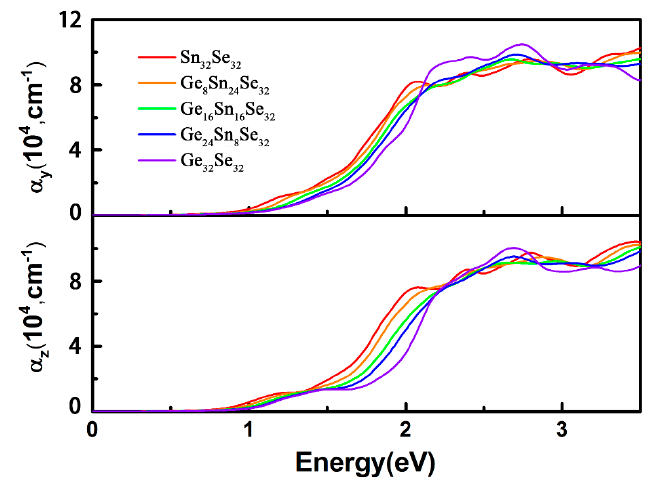
Figure 6. Optical Absorption Coefficients along the y and z Directions of the Ge x Sn 1-x Se Alloys with Different Ge Compositions.